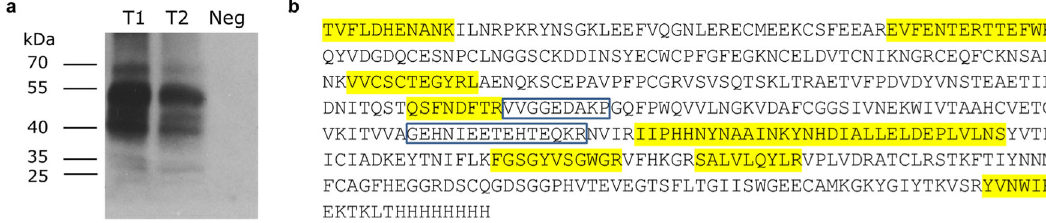
Fig. 4 Analysis on moss-produced FIX protein isoforms. a Immunodetection of extracellular FIX produced by two transformations (anti-FIX Ab 1:5,000). Culture supernatant of non-transfected cells was used as negative control (Neg). T1, T2: Two different transient transformations with the FIX cDNA-based expression plasmid. b Full-length mossFIX amino acid sequence. Amino acids marked in yellow were identi fi ed in the MS analysis. Blue boxes mark the parts of the peptide VVGGEDAKPGEHNIEETEHTEQKR that was identi fi ed in MS analysis and represents a heterosplice